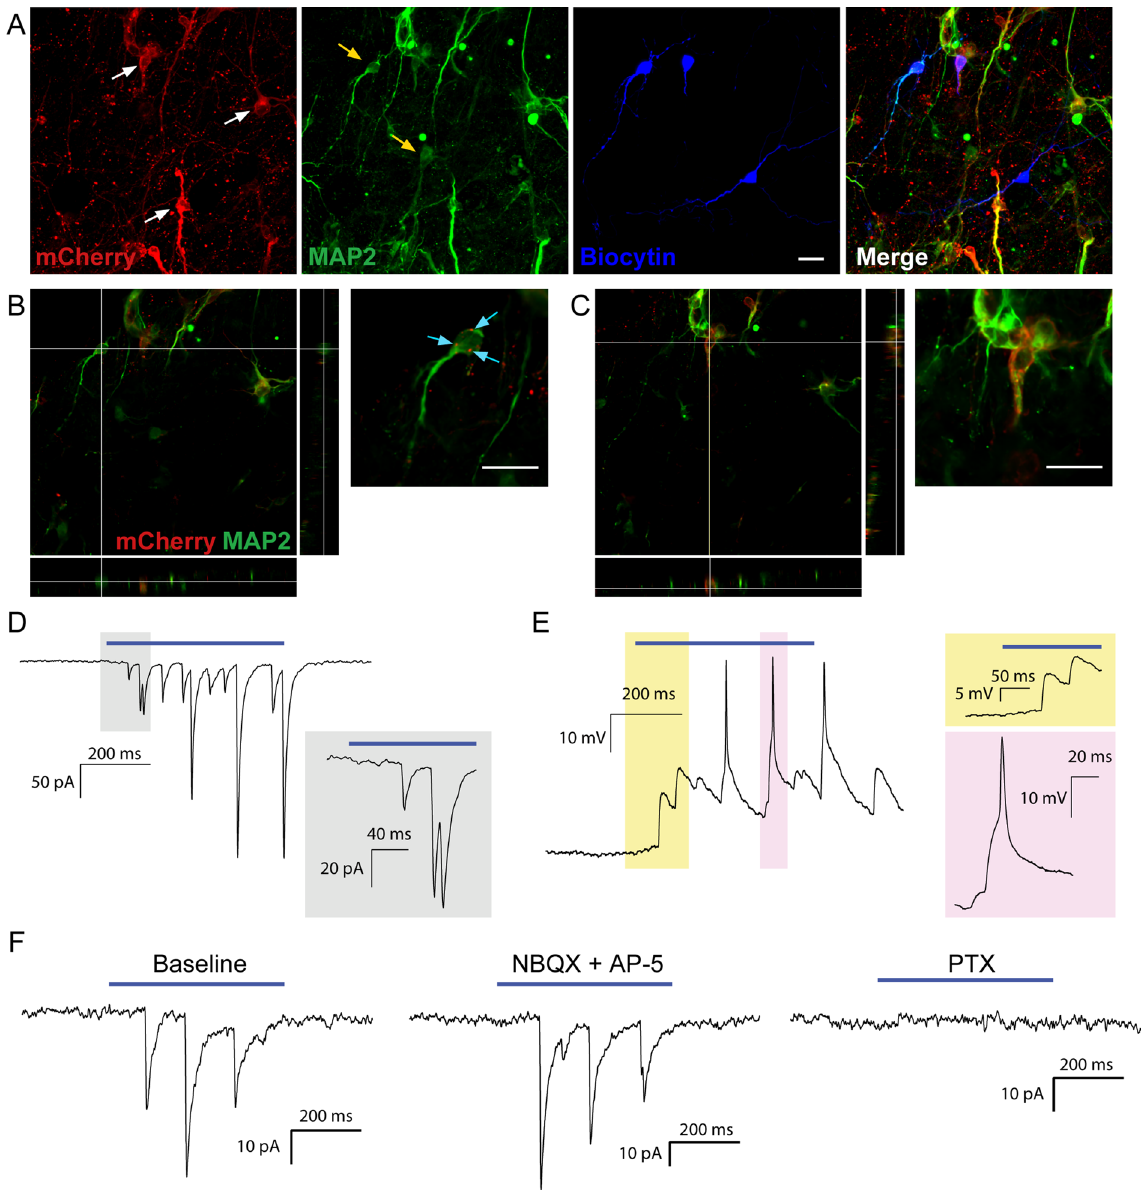
Figure 7. Grafted hdINs established functional efferent synaptic connections to the host adult human neurons. ( A ) hdINs survive and differentiate after transplantation onto human organotypic brain cultures for 4–6 weeks AT. hdIN-mCherry + neurons are indicated with white arrows, and host neurons are marked with yellow arrows (mCherry-/MAP2 +). ( B ) Orthogonal projection of a host neuron and magnification on the right. There are mCherry + processes surrounding the host neuron (cyan arrows). ( C ) Orthogonal projection of a hdIN mCherry + neuron, which is also MAP2 +. ( D ) Delayed synaptic response in voltage-clamp mode of the host neuron after optogenetic stimulation of the hdINs by a 500 ms light pulse, indicating synaptic integration of those cells in the pre-existing neuronal network at 4 weeks AT. ( E ) Delayed synaptic response in current-clamp mode of the host neuron after optogenetic stimulation of the hdINs, illustrating changes of the membrane potential (magnification in yellow), that eventually leads to the generation of an AP (magnification in pink). Note that the GABA A receptor-generated currents are depolarizing in the host recorded cell because a high chloride solution was used in the patch pipette. These responses in the host neurons were blocked by PTX (right column in F ), but not by NBQX + AP5 (middle column in F ), confirming their GABAergic nature. Scale bar: 20